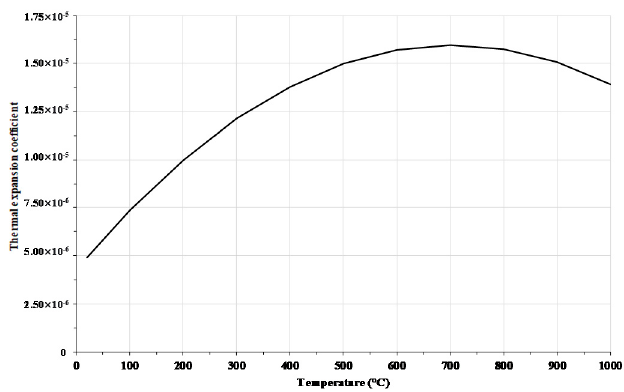
Figure 9. Thermal expansion coefficient of ASTM A572-50 steel.